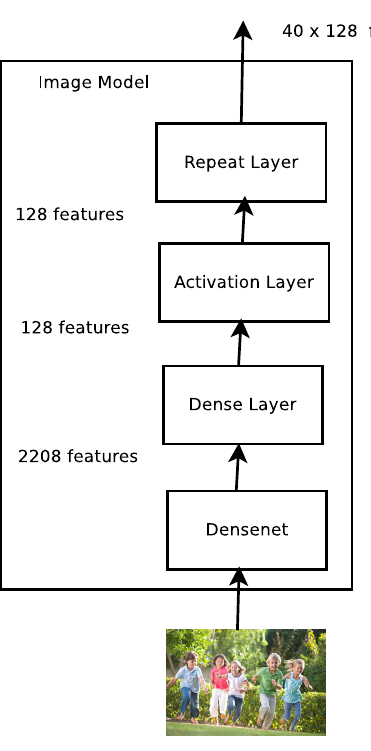
Figure 1. Architecture of the proposed model.